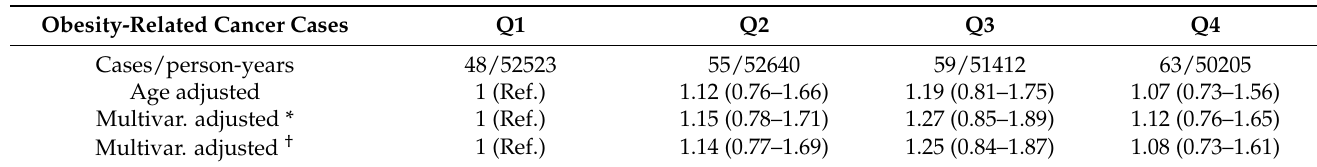
Table 3. Hazard ratio (95% CI) of obesity-related cancer according to energy-adjusted quartiles of dietary vitamin D intake.